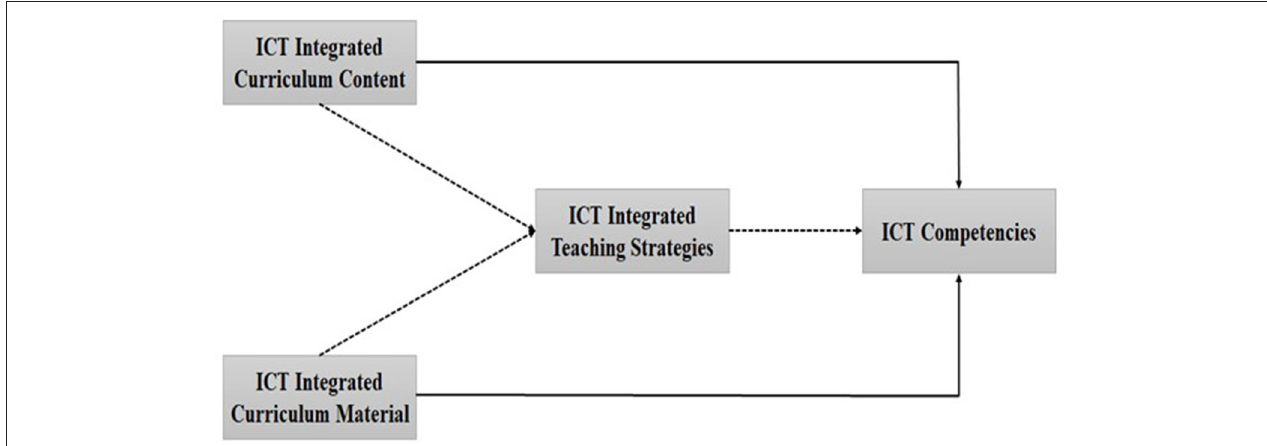
FIGURE 1 | Research framework. Dotted lines show hypothesized indirect relationships. Solid lines show the direct relationship between constructs used in the framework. among students in blended learning set up of China.